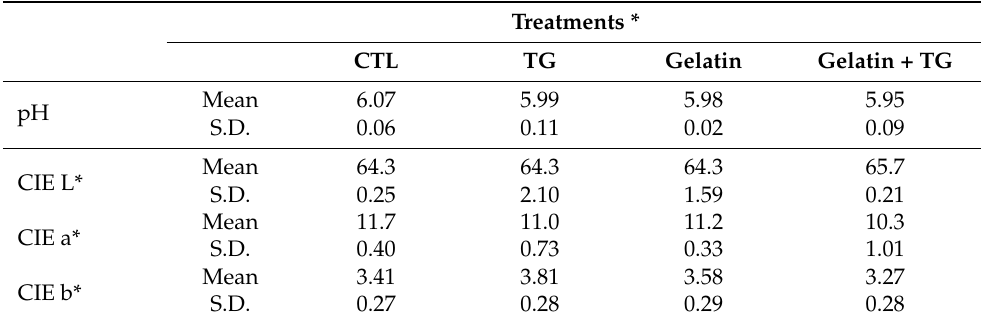
Table 2. pH and color of restructured ham with gelatin and transglutaminase.